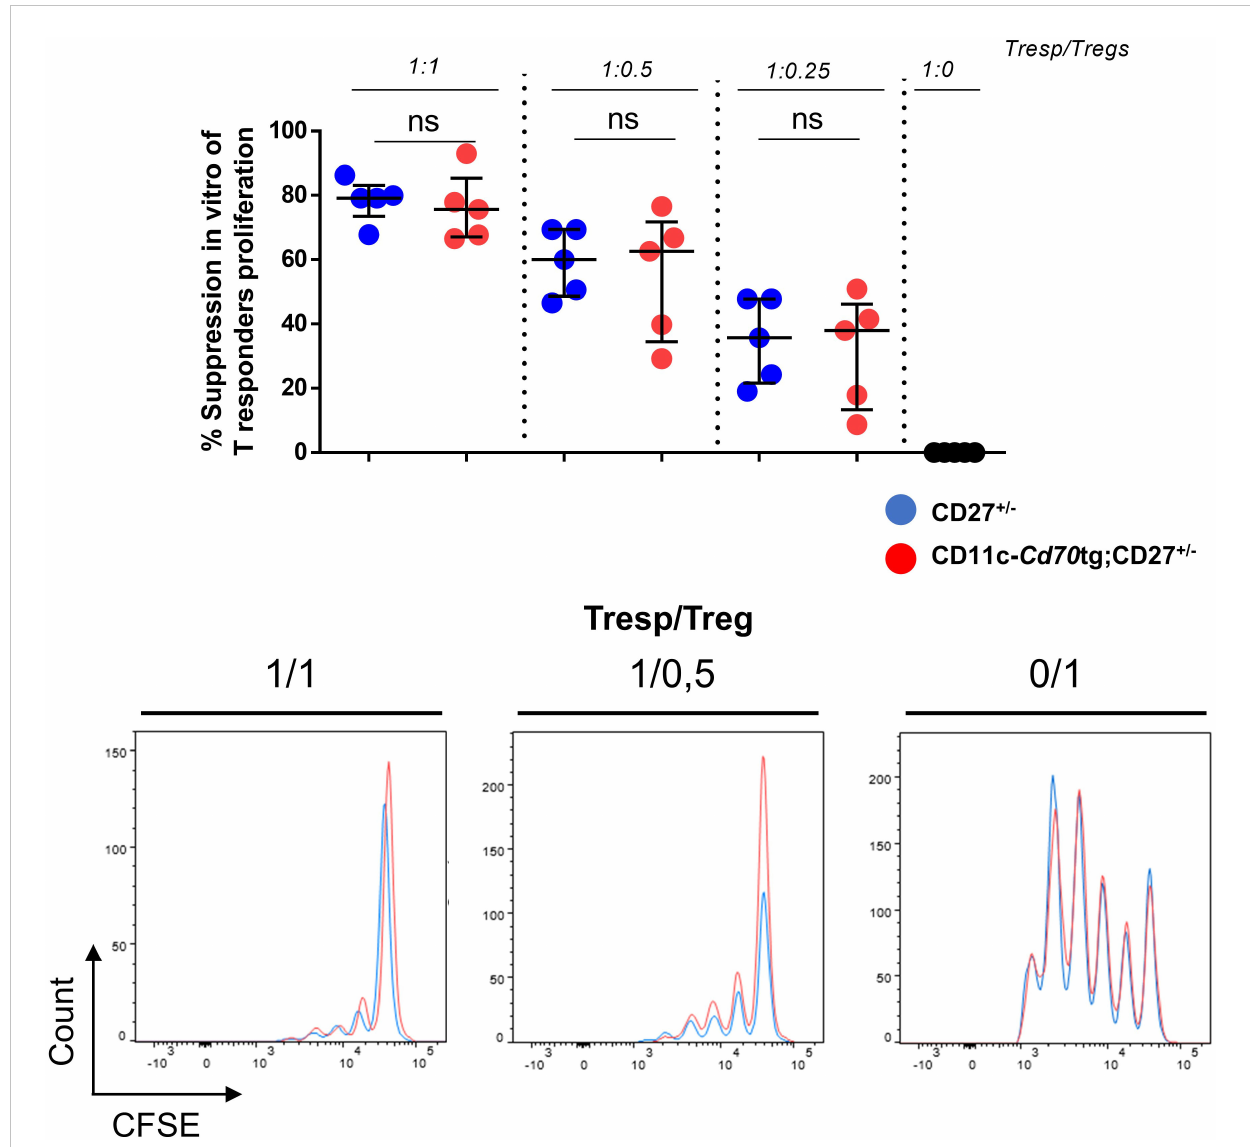
FIGURE 4 Unchanged suppressive capacity of Tregs in CD11c- Cd70 tg;CD27 +/- mice. CD4 + Foxp3 + cells were sorted from CD27 +/- or CD11c- Cd70 tg;CD27 +/- mice and co-cultured with CFSE-labeled, naive conventional CD4 + T cells from CD45.1 mice in the presence of soluble anti-CD3 mAb and irradiated splenocytes. After 3 days, fl ow cytometry pro fi les of CFSE were analyzed. Percent of suppression of proliferation as compared to cultures in which Treg cells were omitted. Data are representative of 4 independent experiments with n = 5 per group. Values are presented as the median ± SD and were compared by two-tailed unpaired student ’ s t-test. ns, not signi fi